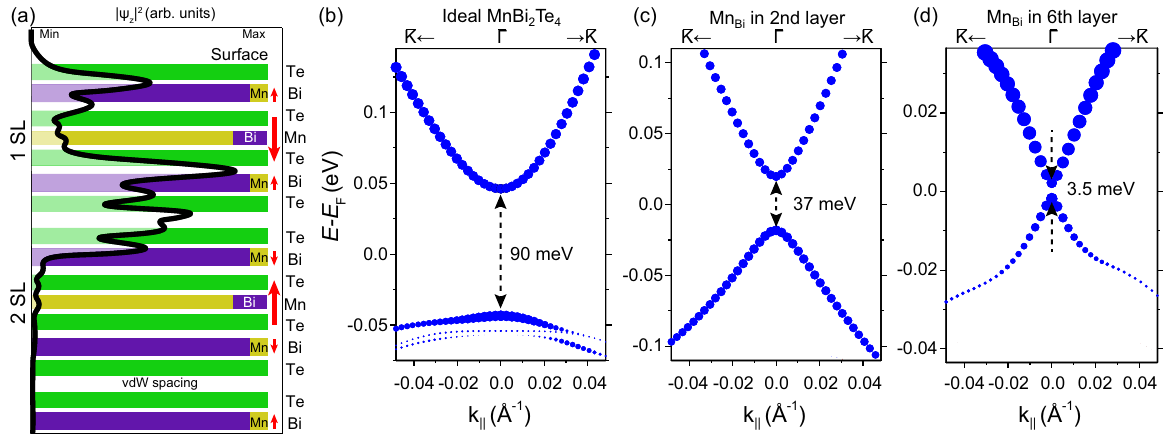
Fig. 5 DFT surface electronic structure calculations of ideal and defective MnBi 2 Te 4 . a Illustration of the TSS real space distribution at the MnBi 2 Te 4 (0001) surface. The ∣ Ψ z ∣ 2 pro fi le corresponds to the band structure shown in panel b . The color coding for the atoms sorts is the same as in Fig. 1a. Unlike in the case of the ideal structure (Fig. 1a), the Mn-Bi intermixing leads to the appearance of the Mn Bi magnetic moments in the Bi layers that are coupled antiparallel to those in the central Mn layer of the same SL. The Mn Bi magnetic moments thus turn out to be located in the regions with a high weight of the TSS, strongly counteracting the effect from the magnetization of the central Mn layer, where the TSS weight is low. This is expected to lead to a strong reduction of the DP gap. The latter is illustrated in panels ( b – d ), where the MnBi 2 Te 4 surface electronic structure in the defectless case ( b ) is compared to those with Mn-Bi intermixing when Mn Bi defect locates in the second ( c ) and sixth ( d ) atomic (Bi) layers counting from the surface (see a ). Note that only the topological surface state is shown, while the bulk-like bands are omitted. The energy axes scales in ( b , c ) and ( d ) are